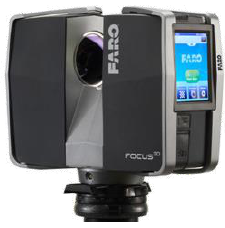
Figure 3. Faro Focus 3D S 120.